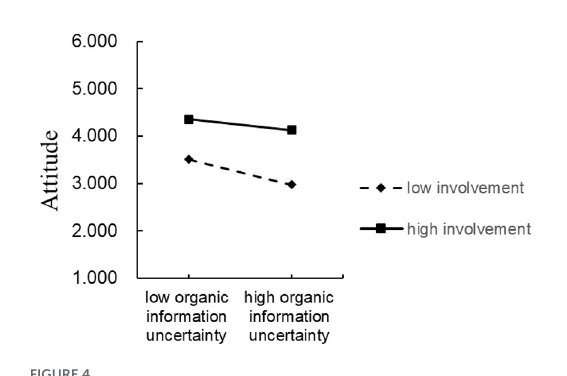
FIGURE4 Interaction between organic food information uncertainty and